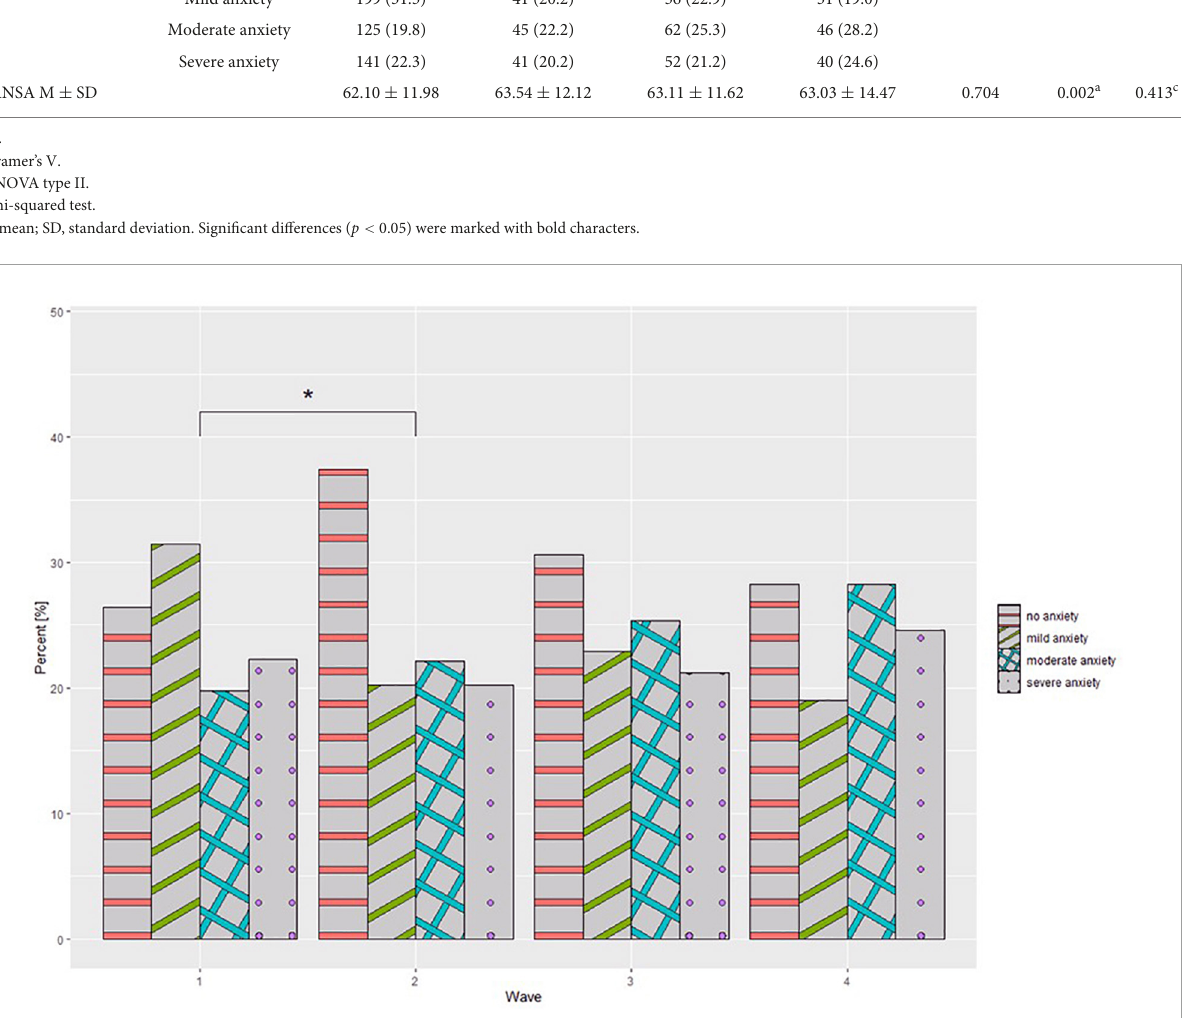
FIGURE1 Generalized Anxiety Disorderd-7 (GAD-7) interpretation at different stages of the study. * p <